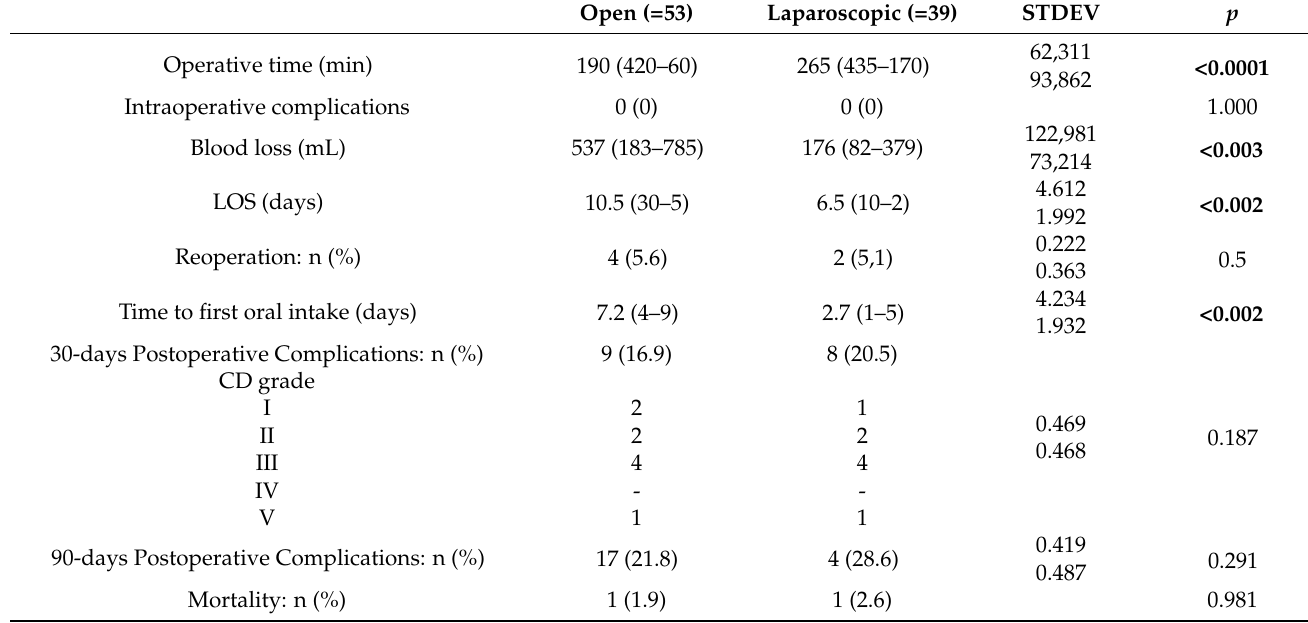
Table 2. Surgical outcomes of the two groups: univariate analysis.